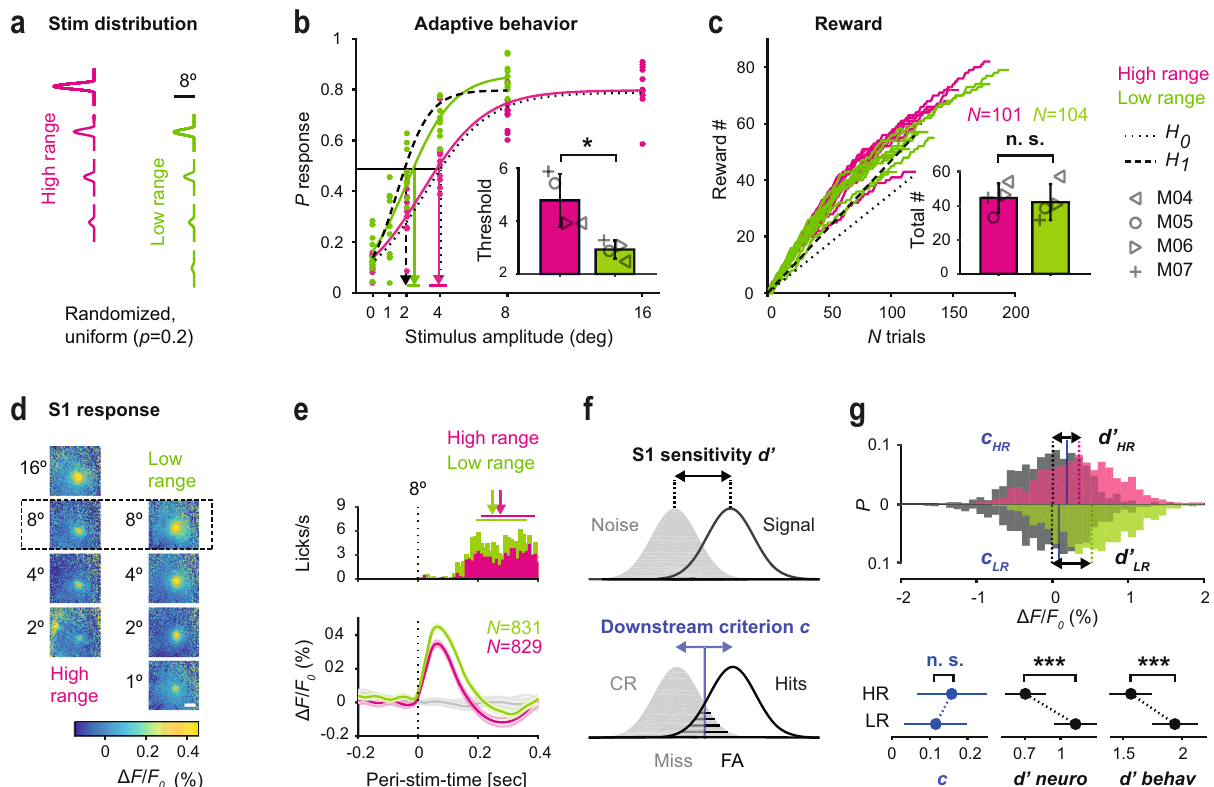
Fig. 3 Adaptive behavior and S1 responses. a Manipulation of the stimulus distribution range. Every stimulus is presented with equal probability ( P = 0.2). The design involves amplitudes common to both high range (magenta) and low range (green) conditions. b Psychometric curves and response thresholds for an example animal working on both conditions. Each dot corresponds to response probabilities from a single session. Solid curves are logistic fi ts to the average data ( n = 10 – 11 sessions). Dotted line is a hypothetical curve assuming no change in performance ( H 0 ). Dashed line is a hypothetical curve assuming a change in performance to maintain reward ( H 1 ) when switching from high range to low range stimulus distributions. Response thresholds are shown as vertical lines with 95 % con fi dence limits. Inset. Response thresholds of all mice (gray symbols). Bars represent means across mice with SD ( n = 4). * P = 0.03, two-sided Wilcoxon rank-sum test. c Number of rewards (correct trials) accumulated by the same animal from b . Each line corresponds to one session. Figure conventions are the same as in b . Inset. Average total reward number per session for each mouse. The average number of trials is shown on top. n.s. not signi fi cant, P = 0.69, two-sided Wilcoxon rank-sum test. d Frames of evoked cortical fl uorescence activity from two example sessions, one with a high range stimulus distribution (left) and the other with a low range stimulus distribution (right). The frames are aligned for amplitudes common to both datasets. Data with a de fl ection angle of 8 degree was chosen for further analysis (outlined box). e Temporal fl uorescent signal in response to 8 degree stimulation, extracted from the region of interest and averaged across sessions and mice. Error bands represent SEM. PSTHs of behavioral lick responses are shown on top. Median reaction times ( fi rst lick post stimulus) are shown as arrows, 25 – 75 percentiles as horizontal lines ( n = 829 – 831 trials). f Observer model based on signal detection theory. Behavioral adaptation can either be induced by changes in sensitivity intrinsic to S1 ( d ′ in black, top panel), changes in decision criterion by a downstream observer ( c in blue, bottom panel), or both. g Top: Distributions of evoked trials (signal) and catch trials (noise) computed separately for the high (HR) and low range (LR) condition. Dashed lines indicate mean Δ F / F 0 , black arrows indicate d ’ values. Blue lines indicate criterion values as computed from ROC curves. Bottom: C and d ′ metrics (neuronal and behavioral). Shown are bootstrapped estimates of means and 95 % con fi dence limits ( n = 38 (LR) or n = 41 (HR) sessions, n = 4 mice, n boot = 1000 repetitions). *** P < 0.001, n. s. not signi fi cant, P = 0.1, two-sided Wilcoxon rank-sum test. reward per trial remains constant (Fig. 3b, black dashed curve; prediction from the maintenance of accumulated reward H 1 ). hypothesis, H 1 (dashed line), while being clearly separable from We observed a shift of the psychometric curve when going the slope representing the null hypothesis, H 0 (dotted line). The from high range to low range performance. The experimentally total number of rewards acquired on average per session and measured psychometric function in the low range condition across all mice further con fi rms this (total # high range = (green) comes quite close to the hypothetical performance, 44.5 ± 8.6, total # low range = 42.0 ± 10.6, Mean and SD, Fig. 3c, suggesting that the animal adapts its behavior to maintain reward. inset), whereas there was no evidence for an alternative strategy to response threshold for all mice (Fig. 3b, inset). Figure 3c depicts the actual trial-by-trial reward accumulation by the example mouse. Overlaid are results for n = 11 sessions with the high range distribution (magenta) and n = 10 sessions with the low range distribution (green). The slope of reward accumulation in the low range condition nearly matches that of the high range Figure 3d shows frames of evoked S1 fl uorescent activity in a condition, and the slope for the low case (green) is close to the mouse exposed to high range stimuli (left) or low range stimuli NATURE COMMUNICATIONS| (2022) 13:534